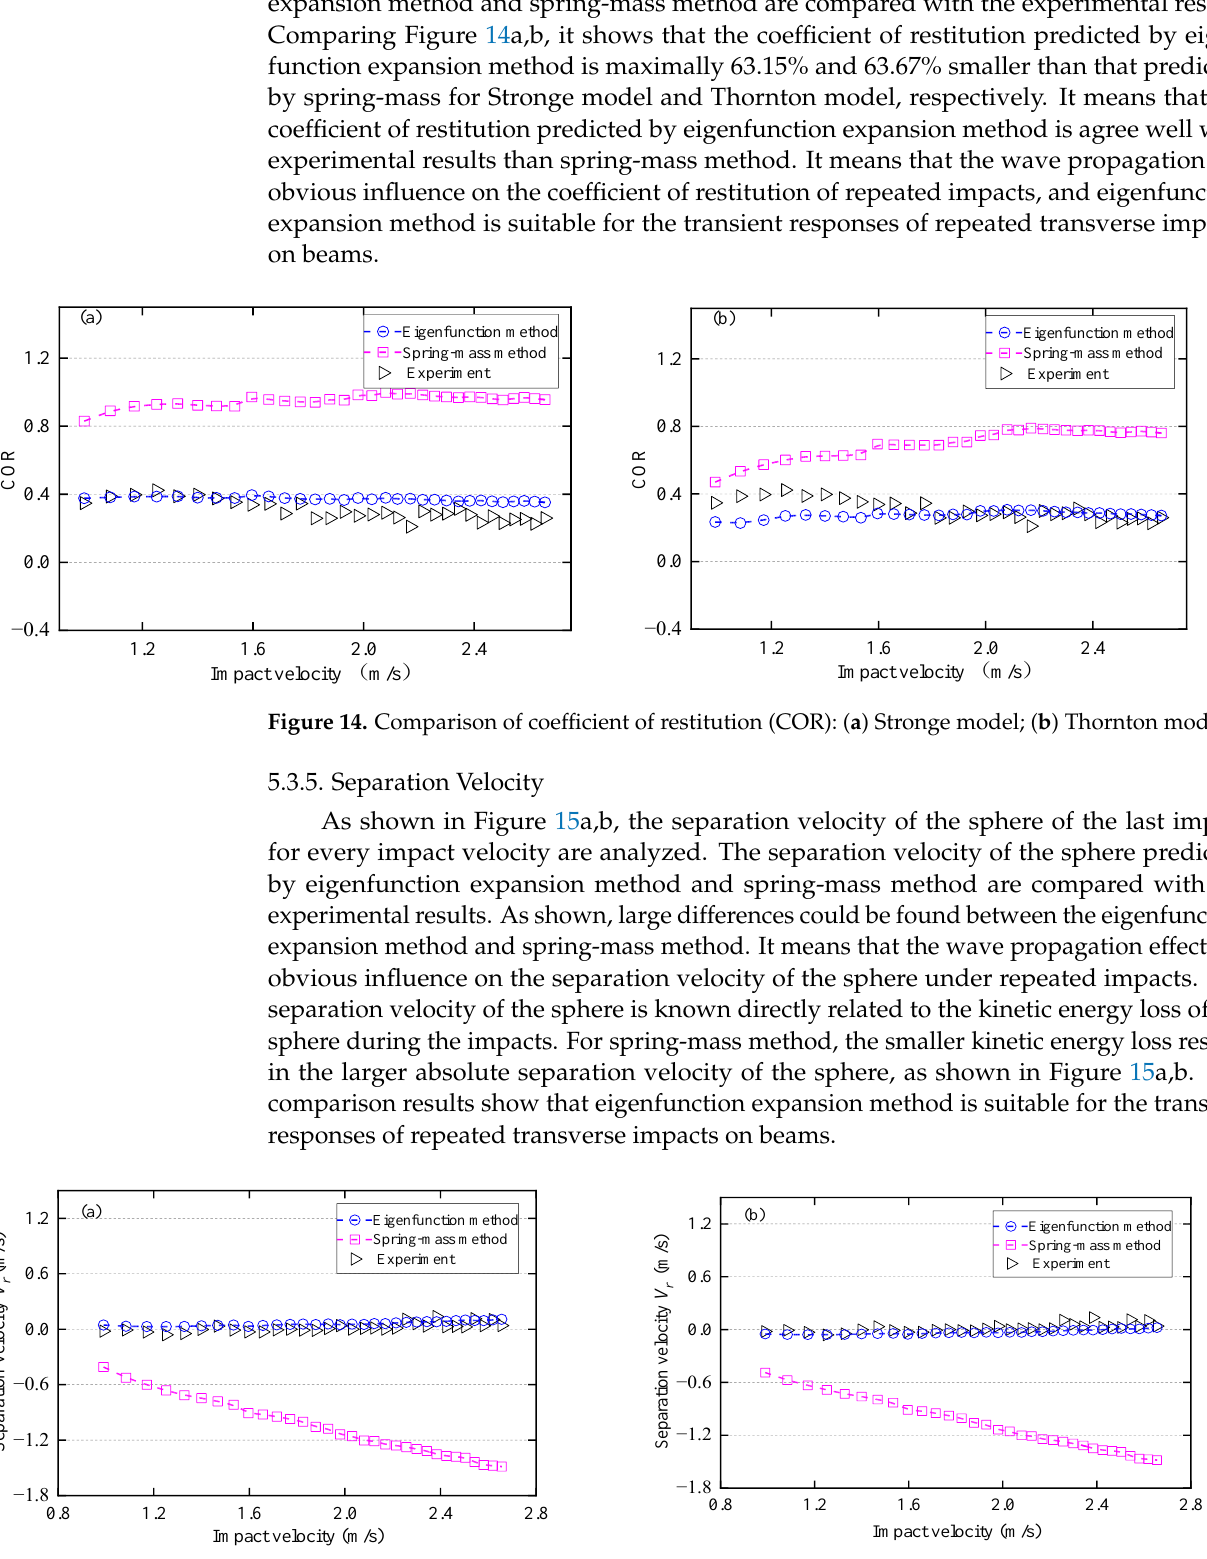
ration velocity of the sphere either positive or negative determines the subsequent motion of the sphere, which determines the occurrence of sub-impact phenomenon [4]. The posi- tive separation velocity of the sphere indicates that the sphere keeps moving in the drop- ping direction and will impact the beam again after finally separation upward and sub- impact can take place. The negative separation velocity of the sphere predicted by using the spring-mass means that the sphere reverses the direction of movement after impact and sub-impact phenomenon can rarely be observed. 6. Conclusions The transient behavior of a flexible beam, driven by repeated transverse impact of a spherical projectile, are investigated in this study. T he eigenfunction expansion method is firstly presented to solve the transient structure responses of beams. Then the new method can be used to solve the repeated impact responses of beams by combining the local con- tact models. In order to verify the validity, the results of the new method as well as the spring-mass model are compared with the experimental data, where a simply-supported beam is repeatedly struck by a sphere. The main findings are concluded as follows. (1) The eigenfunction expansion method could predict the wave propagation during re- peated impacts on beams, and the results agree well with the experiments. (2) For transient impact behaviors related to energy dissipations, including the accumu- lated permanent indentation, the coefficient of restitution and the separation velocity of the sphere, the results of eigenfunction expansion method agree well with the ex- perimental results, while the results of spring-mass method have large discrepancy with the experimental results. (3) For impact duration, the simulation results of eigenfunction expansion method and spring-mass method both agree well with the experimental results. (4) The differences for the eigenfunction expansion method and spring-mass method are that, for eigenfunction expansion method the energy can be dissipated by wave prop- agations, structural vibrations as well as local contact behaviors, while the spring- mass method only dissipates energy thorough structural vibrations and local contact behaviors. (5) The eigenfunction expansion method appears to be suitable for the transient re- sponses of repeated transverse impacts on beams, especially for the study of impact- induced wave propagations.